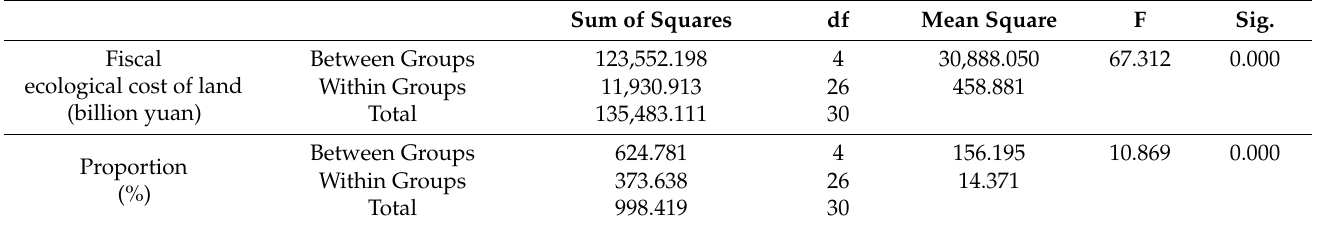
Table 7. One-way ANOVA of land fiscal ecological cost and its proportion to land finance revenue in 31 provinces.